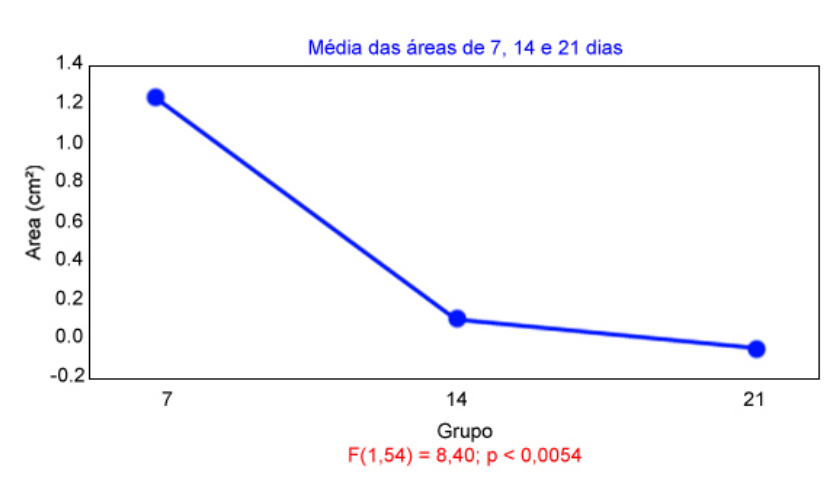
FIGURA 6 - Média das áreas de 7,14 e 21 dias. Legenda: F= Significância da interação, p= Nível de significância.